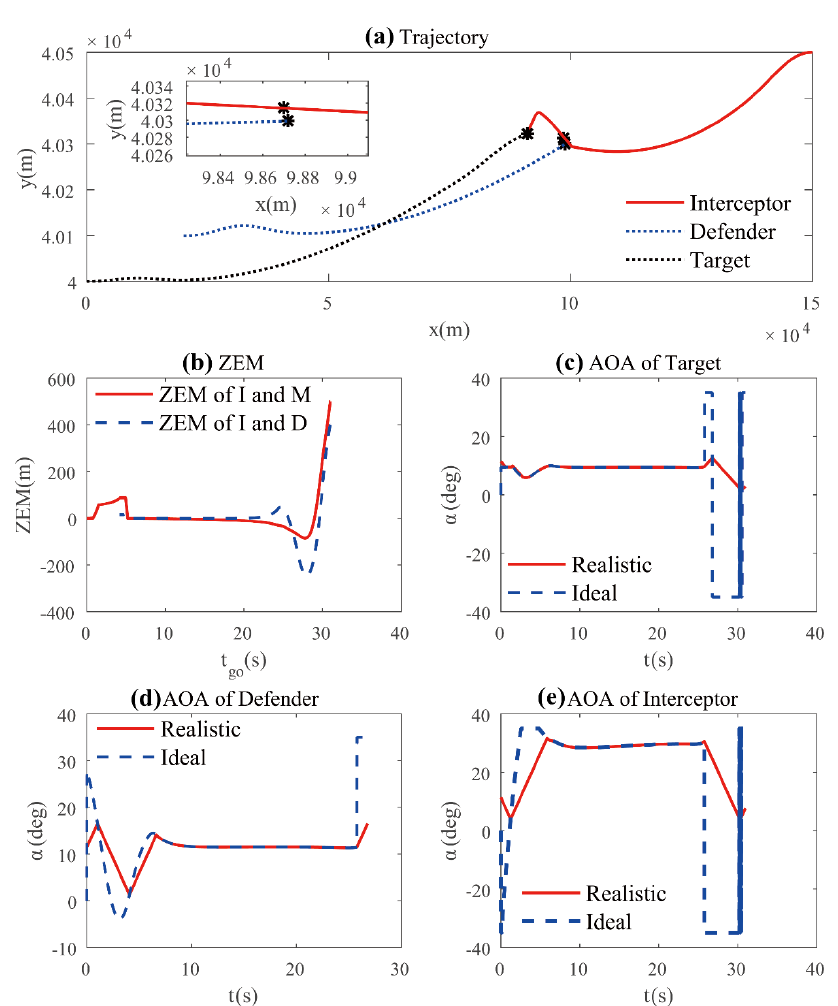
Figure 2. Simulation results of Case 1: ( a ) trajectory; ( b ) ZEM; ( c ) target’s AOA; ( d ) defender’s AOA; ( e ) interceptor’s AOA .